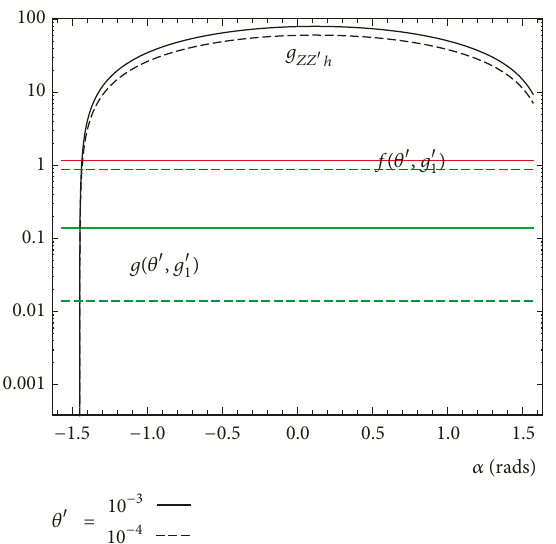
Figure 2: 𝑔 푍푍 󸀠 ℎ (𝜃 耠 ,𝑔 耠 1 ) coupling and 𝑓(𝜃 耠 ,𝑔 耠 1 ) , 𝑔(𝜃 耠 , 𝑔 耠 1 ) functions as a function of 𝛼